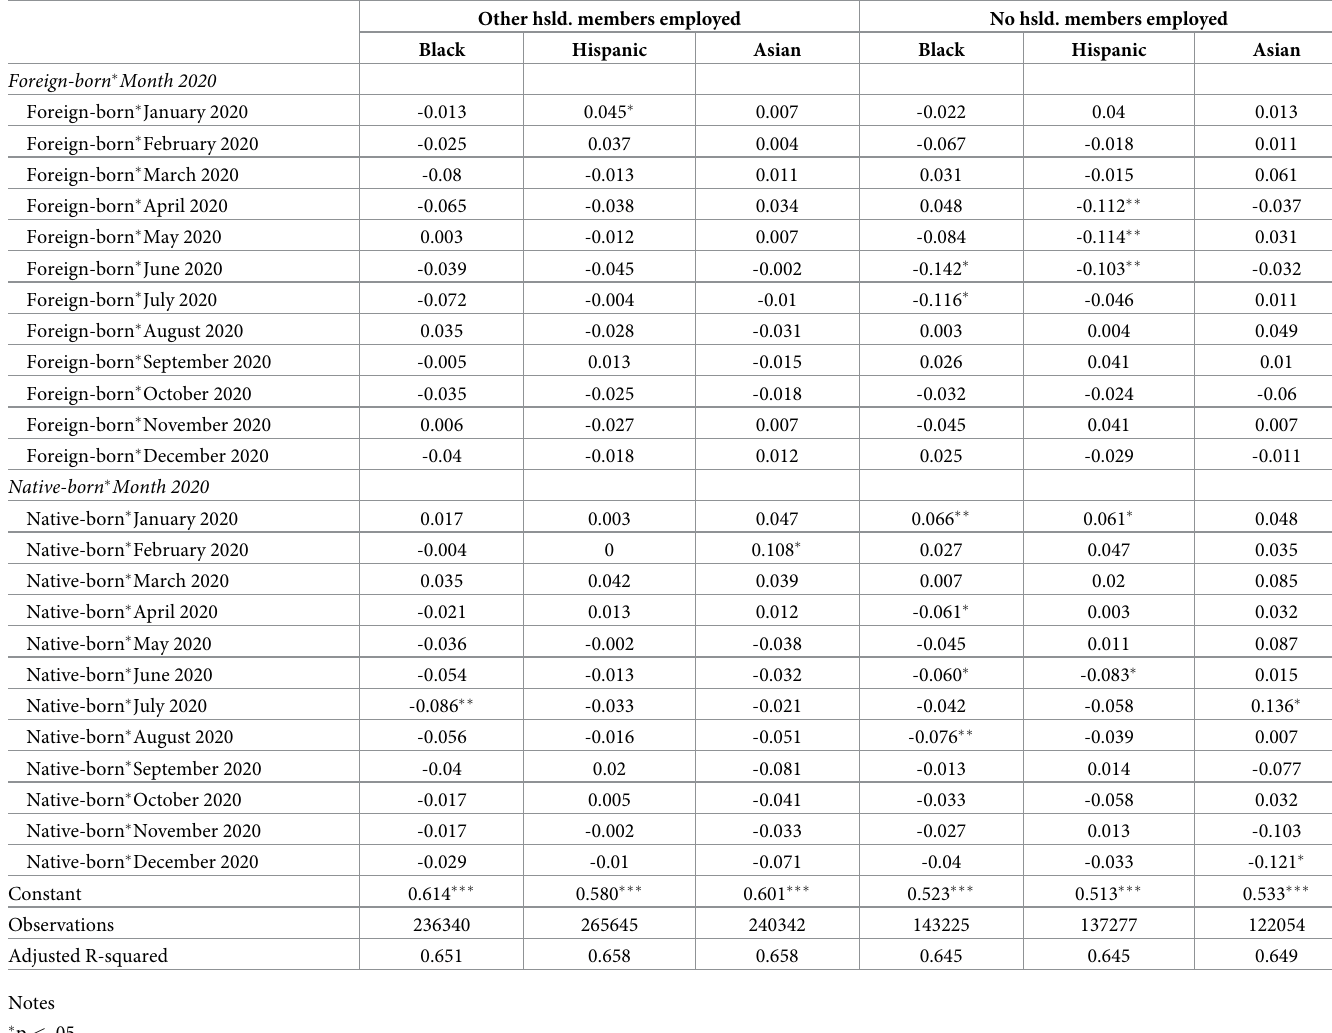
Table 4. Difference in probability of women’s full-time employment relative to native-born Whites by immigrant status, race/ethnicity and employment status of other household members in 2020 relative to 2019. Other hsld. members